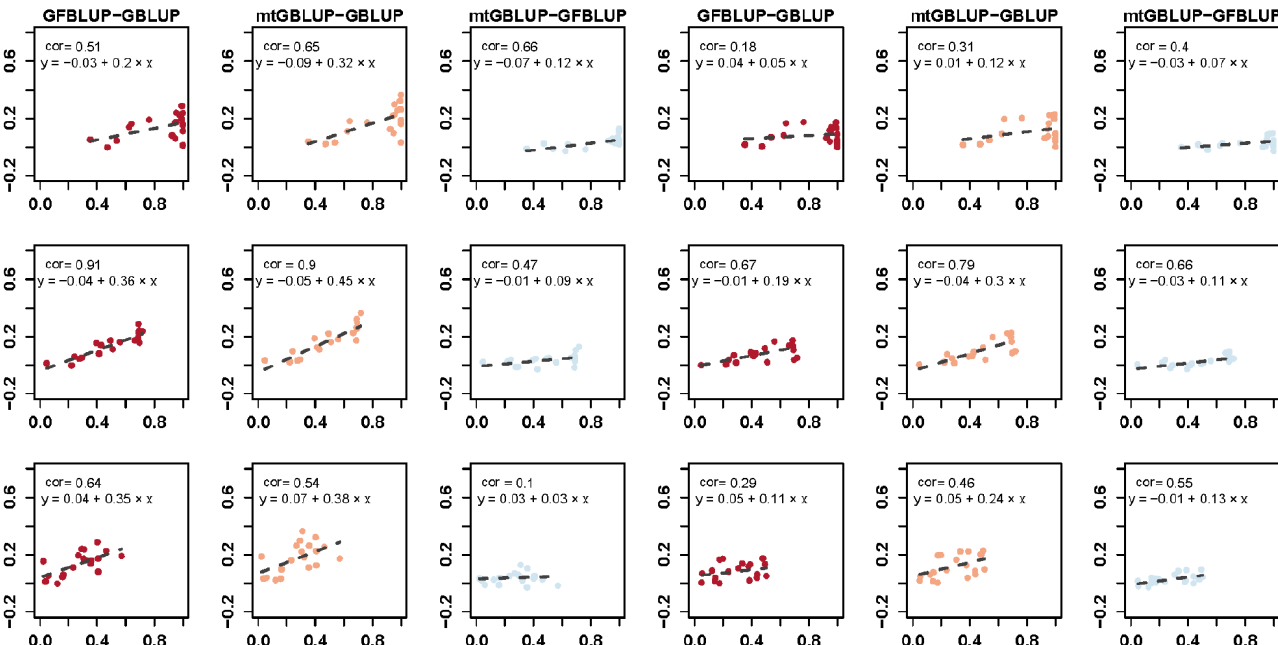
Figure 3. The relationship between the predictive accuracy and estimated genetic parameters for the different models for DS (three columns at left) and WS (three columns at right). y -axis is the deviation of predictive accuracy between models. The correlation coefficient is the Pearson correlation calculated by the prediction accuracy and estimated genetic parameter. Each point represents the prediction accuracy of mean for each trait and the dash line indicates the linear regression fitness between the prediction accuracy and estimated genetic parameter.